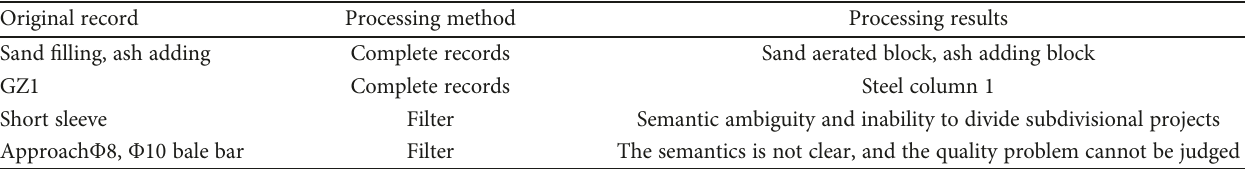
Table 3: Missing value processing records.